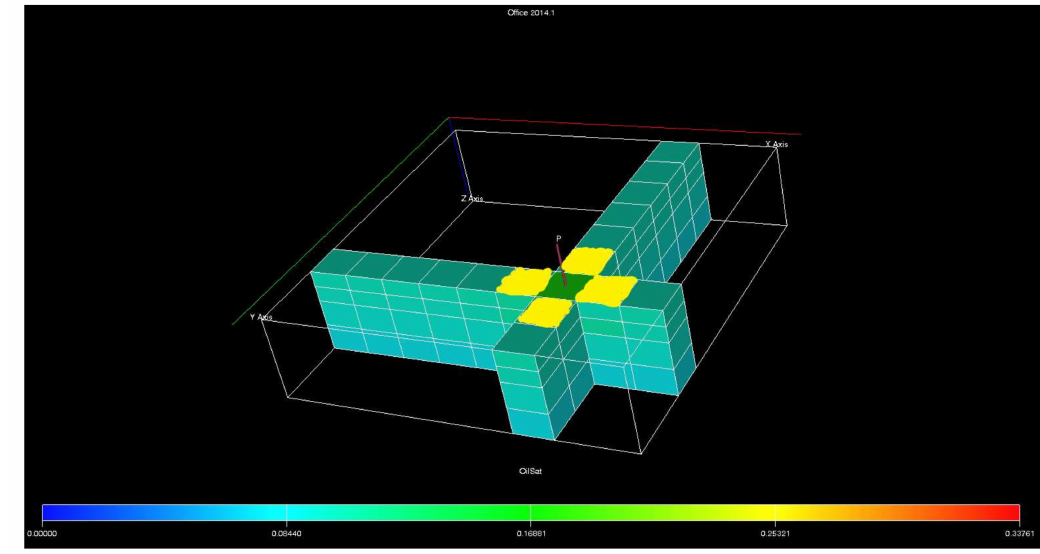
Figure 1. 3D reservoir image for local grid permeability analysis showing the highlighted cells of interest under